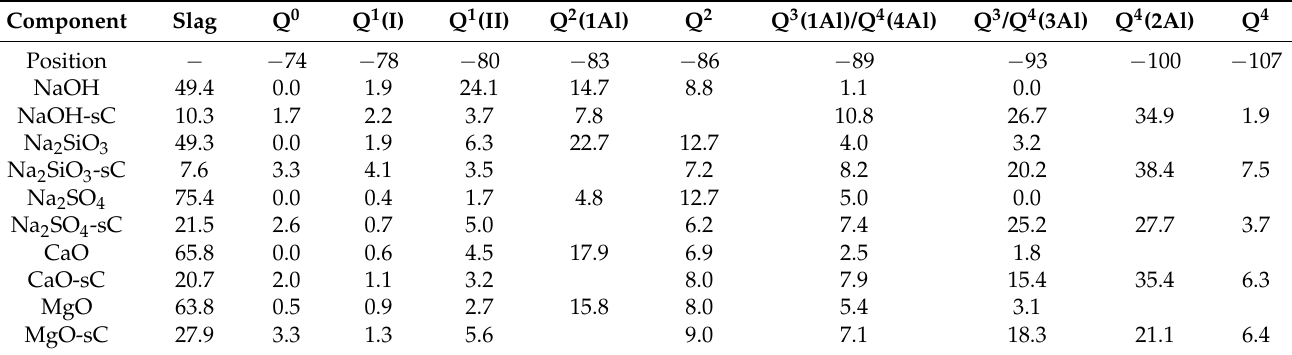
Table 2. 29 Si MAS NMR deconvolution